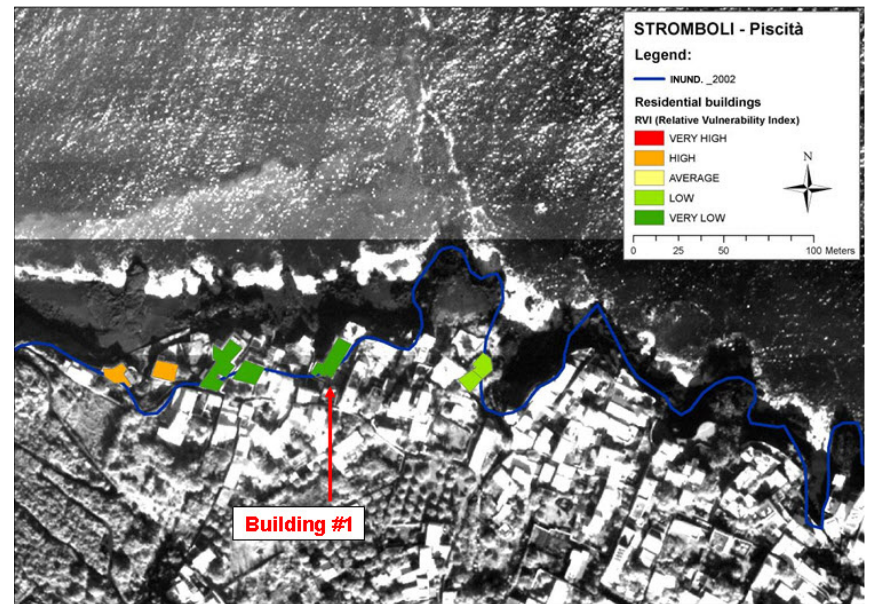
Fig. 4. Vulnerability map of Piscit`a (Stromboli Island). The map layout corresponds to the red frame in Fig. 2. The blue line marks the limit of maximum inundation caused by the 2002 tsunami. Building #1 has been used to validate PTVA-3 Model results. A picture of damage suffered by building #1 during the 2002 tsunami is shown in Fig.